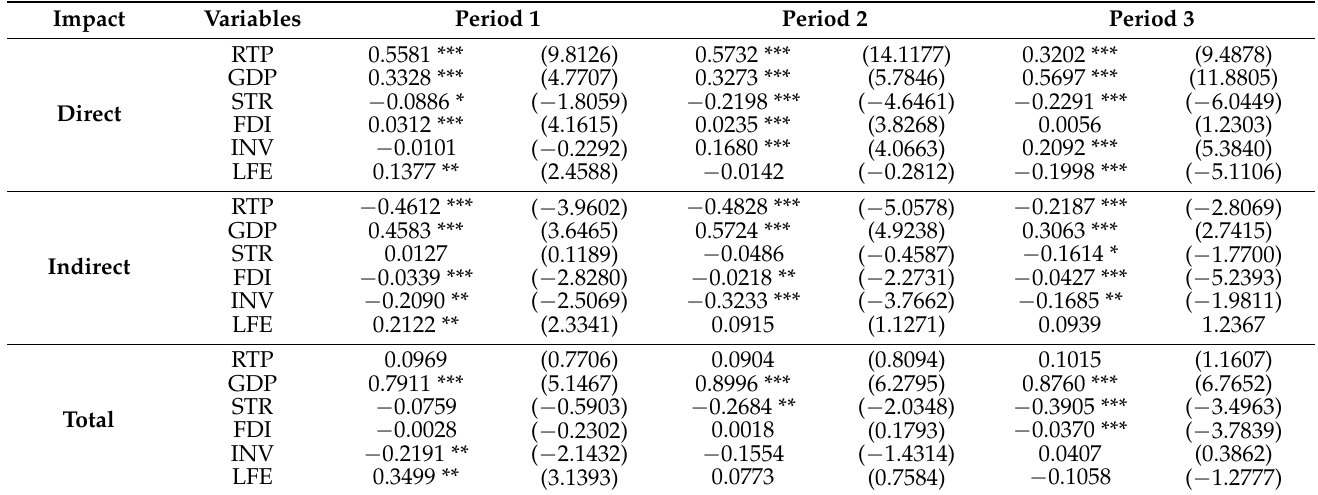
Table 10. Statistical comparison of the regression results obtained during periods 1, 2, and